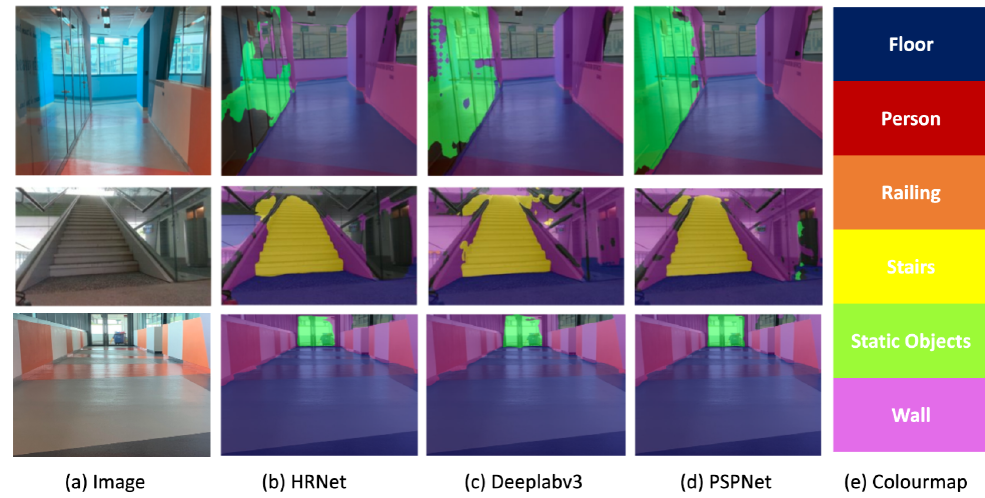
Figure 13. Comparison with other semantic